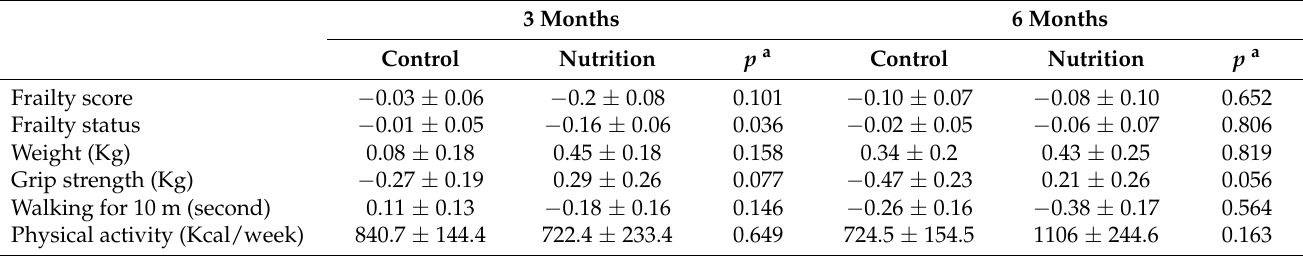
Table 4. Effect of nutrition education program on frailty scores and frailty components 1 .